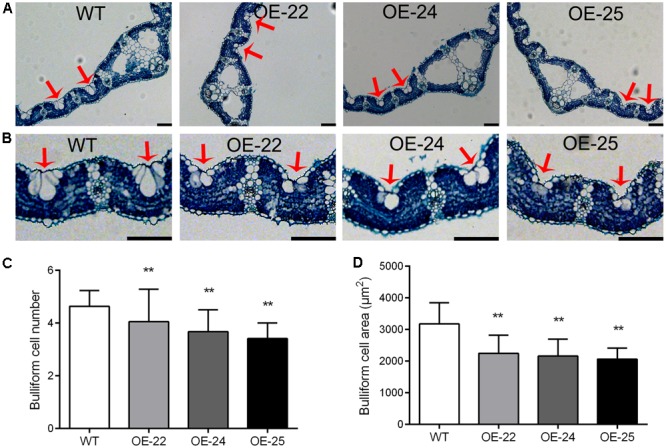
Bulliform cell number and size in the leaves of OE-OsRRK1 plants. (A) Cross sections of flag leaves in WT and OE-OsRRK1 plants. (B) Enlarged view of cell structure of flag leaves in WT and OE-OsRRK1 plants. Bulliform cells are indicated by red arrows. Bars = 100 μm. (C,D) The bulliform cell number (C) and bulliform cell area (D) in the leaves of WT and OE-OsRRK1 plants. Ten samples were investigated. ∗Student’s t-test, P < 0.05; ∗∗Student’s t-test, P < 0.01.